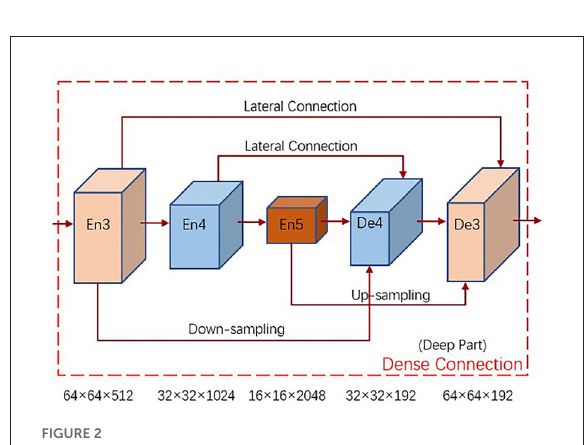
FIGURE2 The dense connection module is used for feature extraction, which can promote the deep feature fusion more